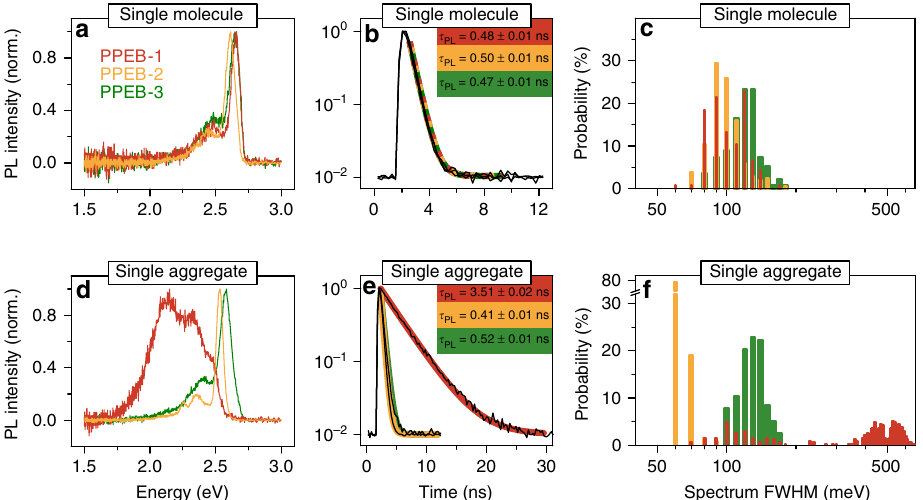
Fig. 4 PL spectra and PL decays of single chains and single aggregates. Normalized PL spectra, transient PL decays, and spectral FWHM values extracted from the spectra in Fig. 3 and plotted in a histogram with 10 meV bin size for single molecules a – c and single aggregates d – f of PPEB-1 (red), PPEB-2 (orange), and PPEB-3 (green) in PMMA measured in air. Transient PL decays were fi tted with an exponential plus an offset to account for the background, yielding the PL lifetimes stated in b and